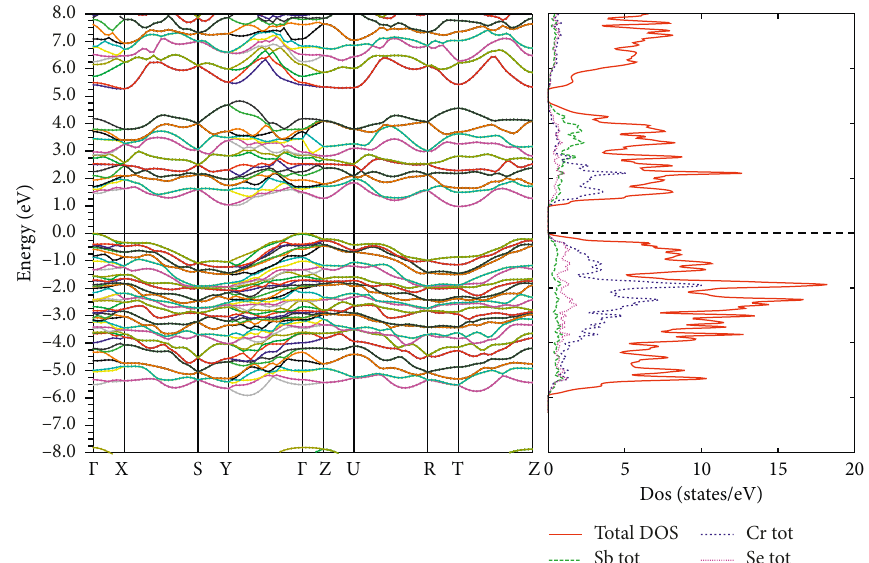
Figure 5: Calculated electronic band structure and density of states for SbCrS